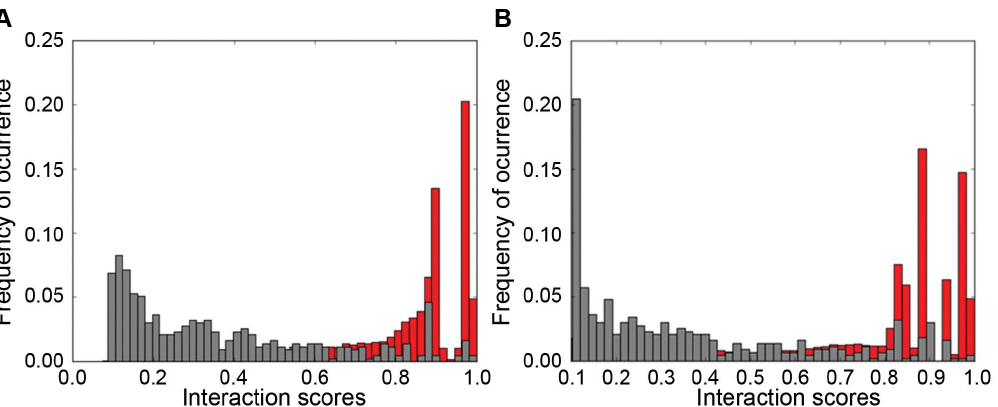
Figure 3. Graphics of classification of the test sets using the F and F 9 Normal combined models. The score represents the classification of the instances as PPI. The instances were classified as PPIs or no-PPIs, and no-PPIs classification scores were converted to interaction scores. ‘‘A’’, classification of the F test set using the F Normal combined model; ‘‘B’’, classification of the F 9 test set using the F 9 Normal combined model; Red, PPIs instances; Gray, no-PPIs instances.